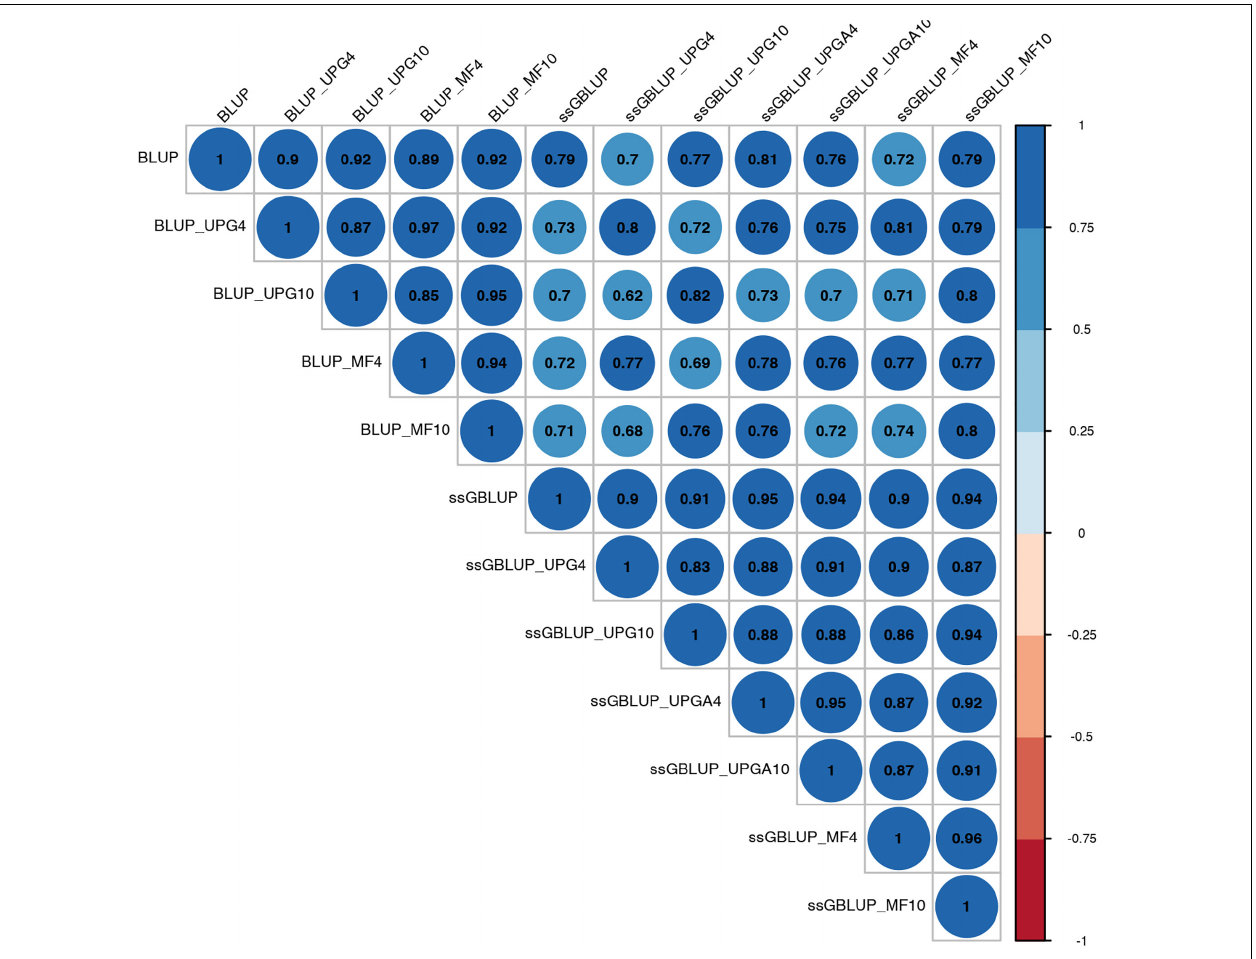
FIGURE 6 | Correlations between breeding values for birth weight maternal estimated using various models with and without genetic